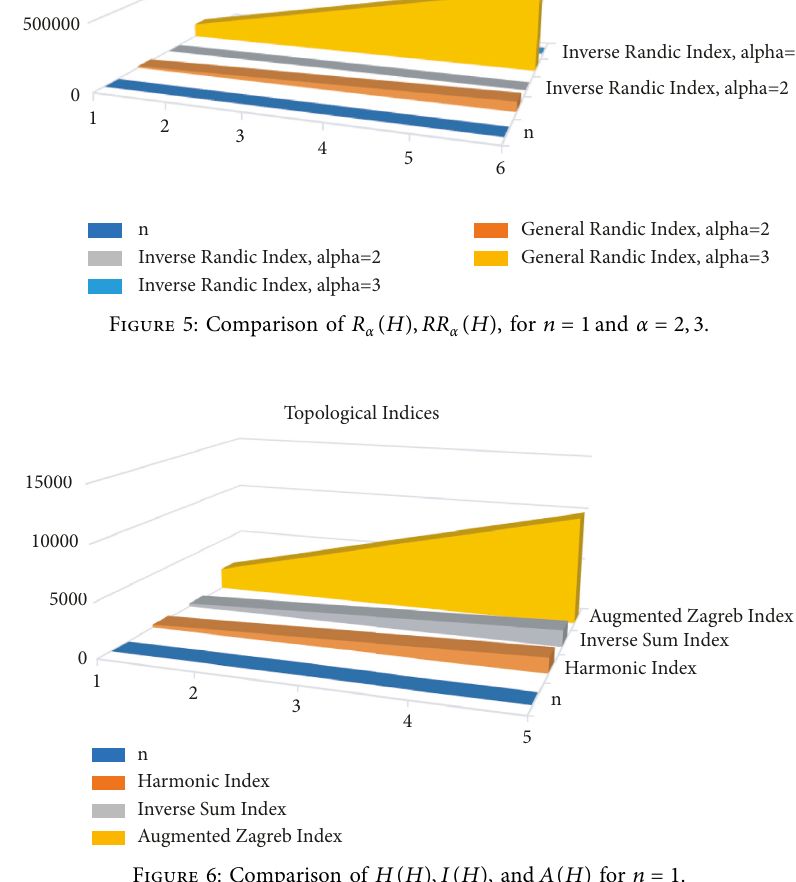
Figure 6: Comparison of H ( H ) , I ( H ) , and A ( H ) for n �